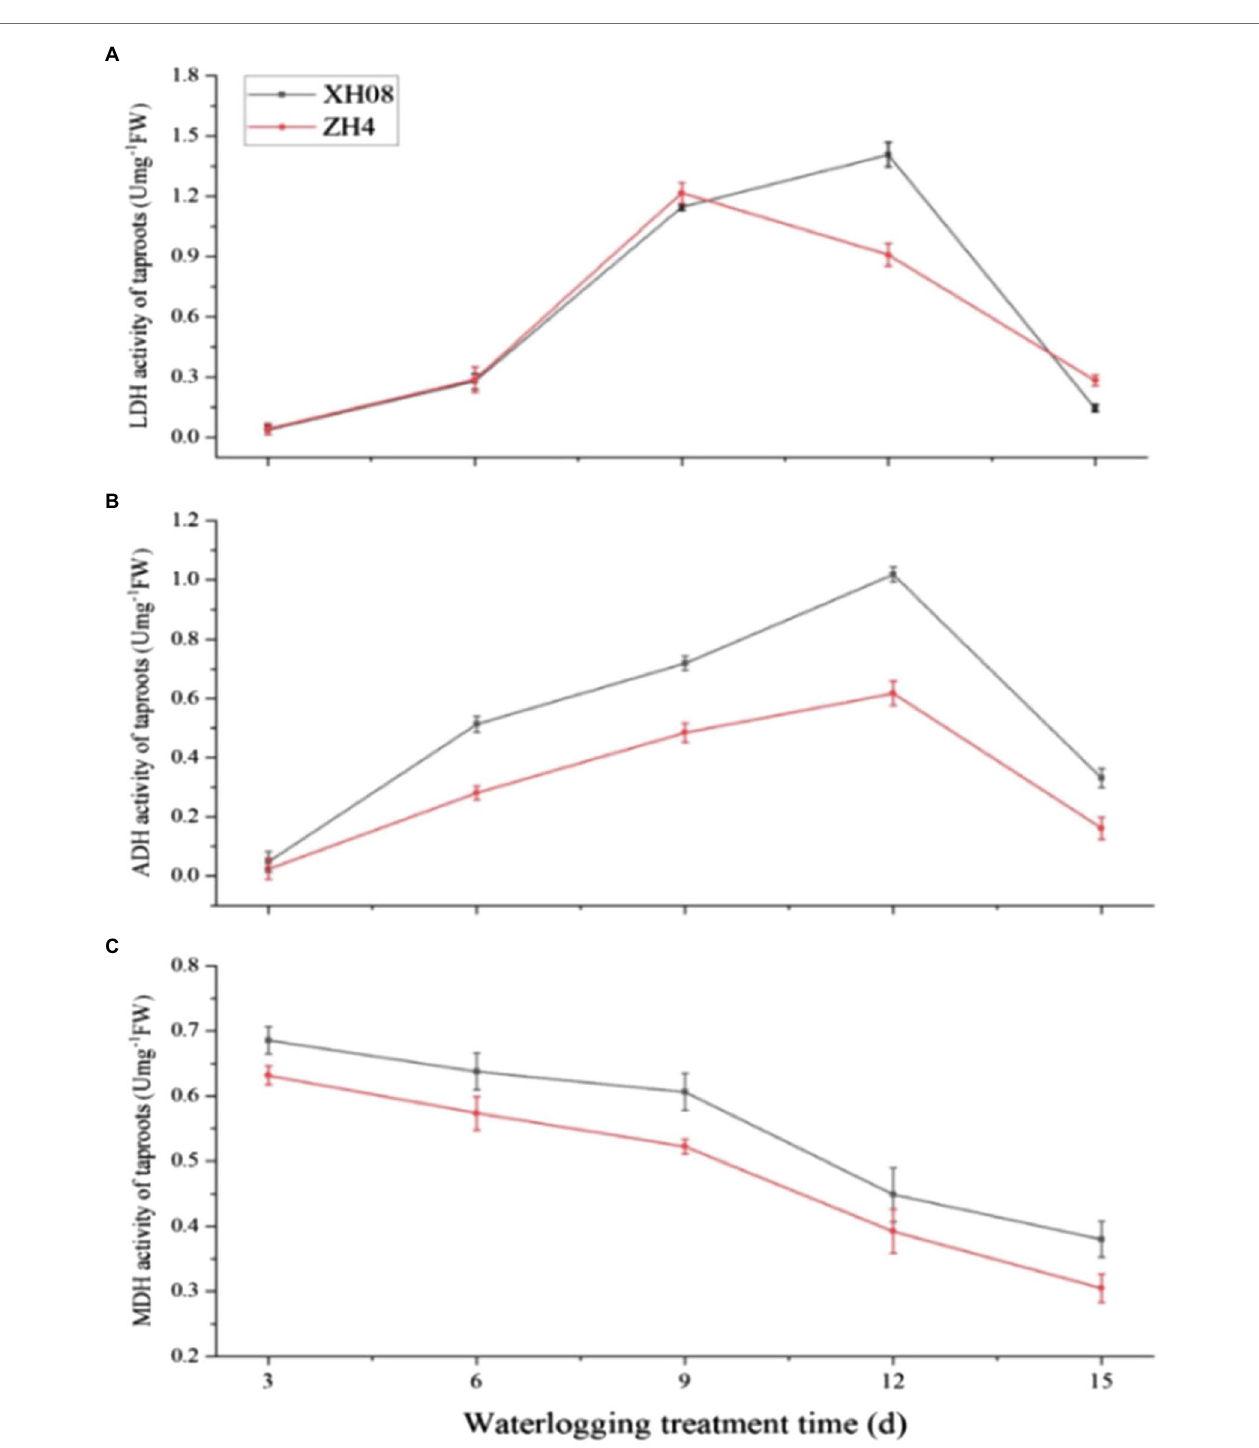
FIGURE 8 | The activities of LDH, alcohol dehydrogenase (ADH), and malate dehydrogenase (MDH) in two peanut cultivars treated with waterlogging for 12 and 15 days. (A) The activities of the LDH enzyme in XH08 and ZH4 after waterlogging treatment for 3, 6, 9, 12, and 15 days; (B) the activities of the ADH enzyme in XH08 and ZH4 after waterlogging treatment for 3, 6, 9, 12, and 15 days; (C) the activities of the MDH enzyme in XH08 and ZH4 after waterlogging treatment for 3, 6, 9, 12, and 15